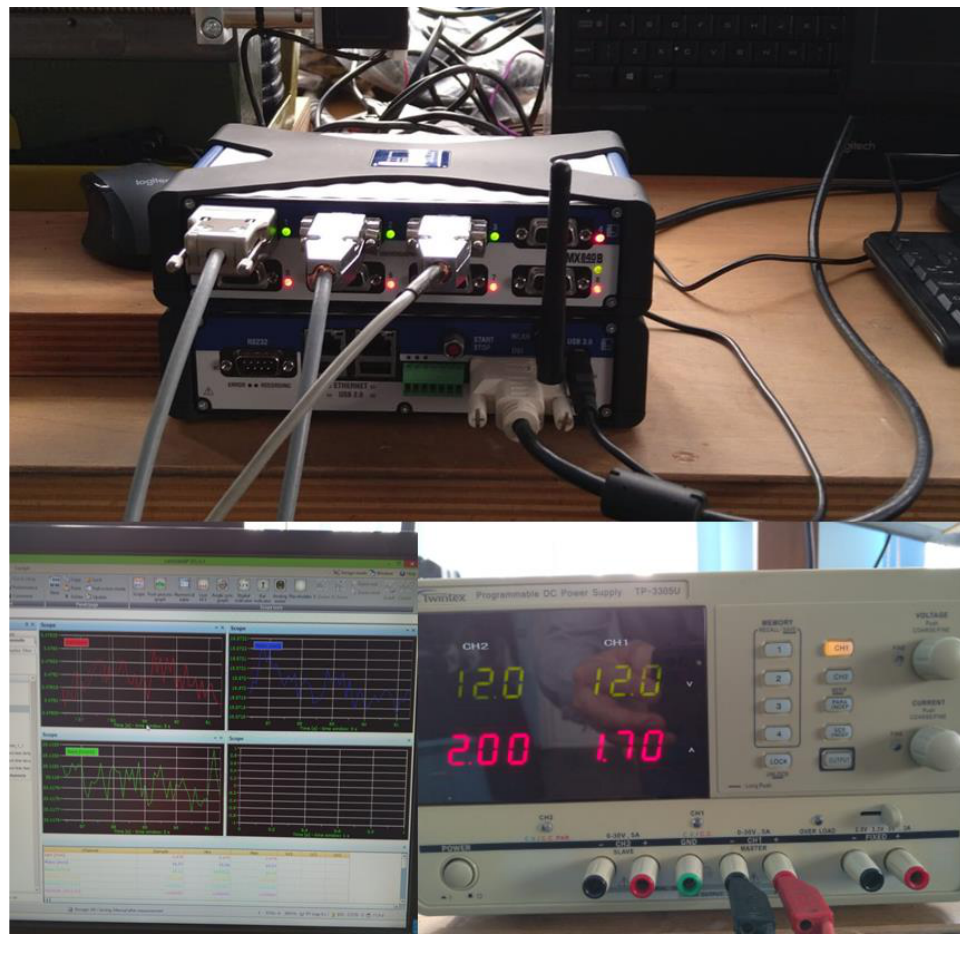
Figure 20. Detail of the experiments.